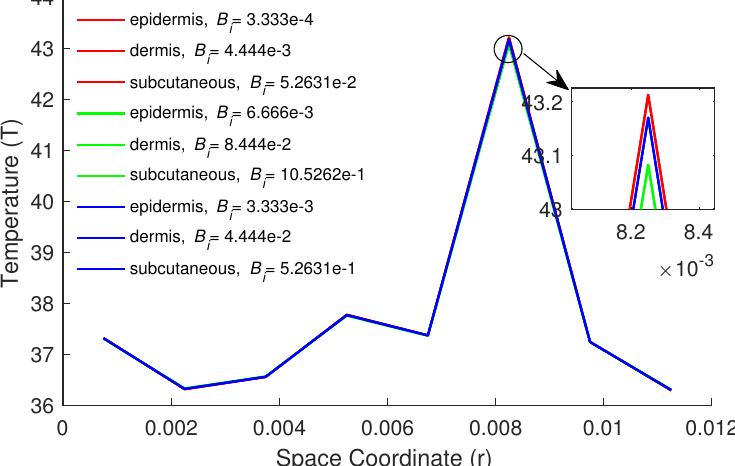
Figure 11. Temperature distributions for different values of B i in third kind